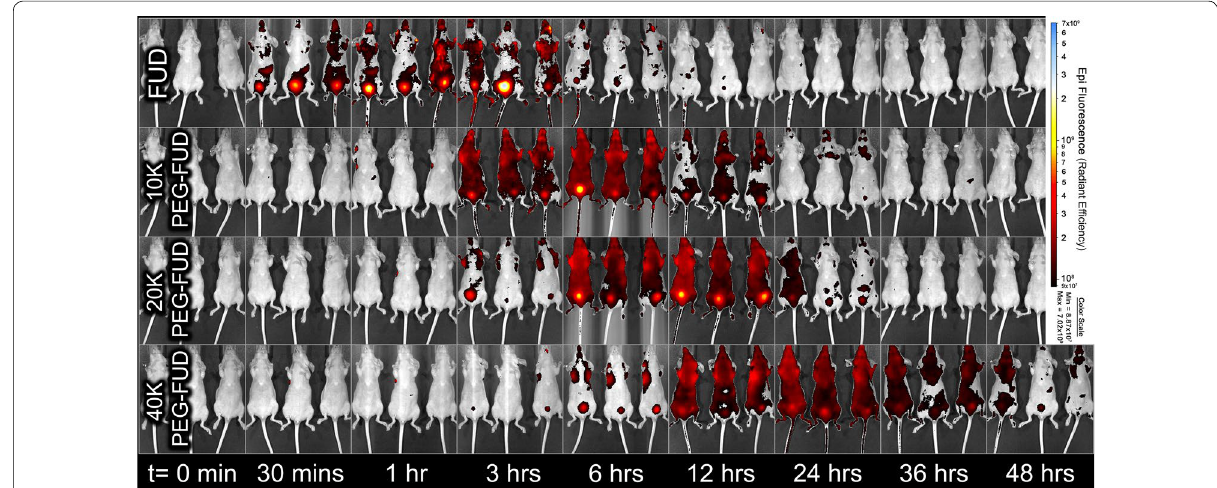
Fig. 11 Ventral views of mice show earlier FUD and PEG-FUD signal in the bladder region for lower MW peptides. A single dose containing a peptide and its sulfo-Cy5 conjugate counterpart was injected s.c. between the shoulder blades of a